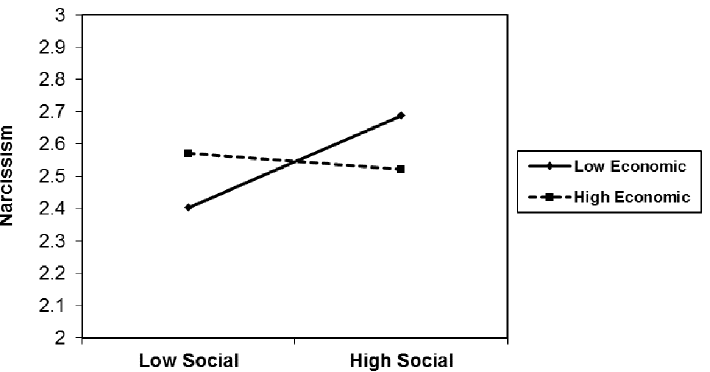
Figure 5. The Study 2 interaction between social and economic political ideology (measured via single-item measures) in relation to